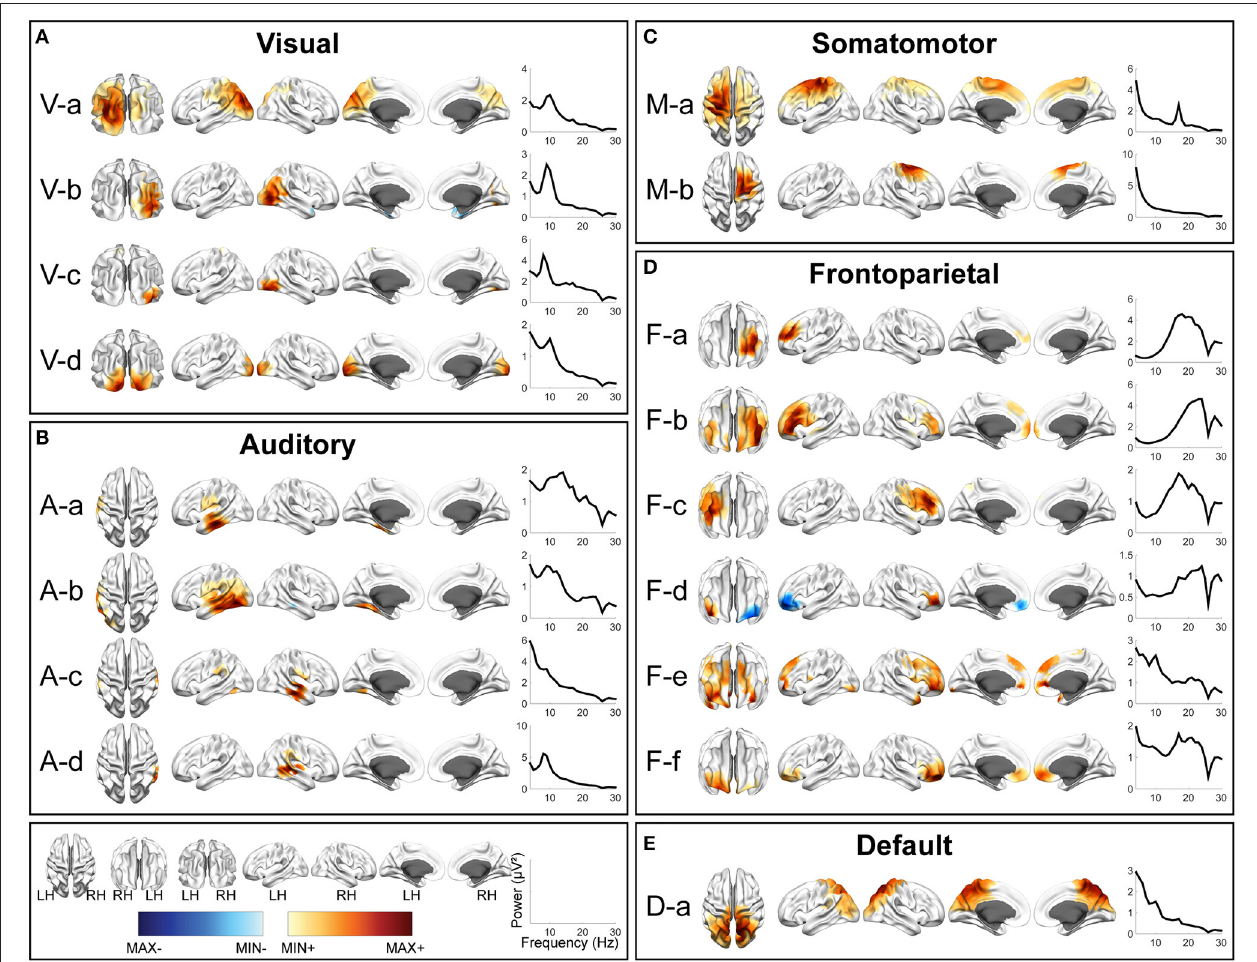
FIGURE 2 | Spatial and spectral patterns of five RSN classes from TFICA-SCT on the EC/EO EEG data. (A) Visual, (B) auditory, (C) somatomotor, (D) frontoparietal, and (E) default mode networks. Group-level SCT maps were thresholded at p < 0.01, cluster-based correction.